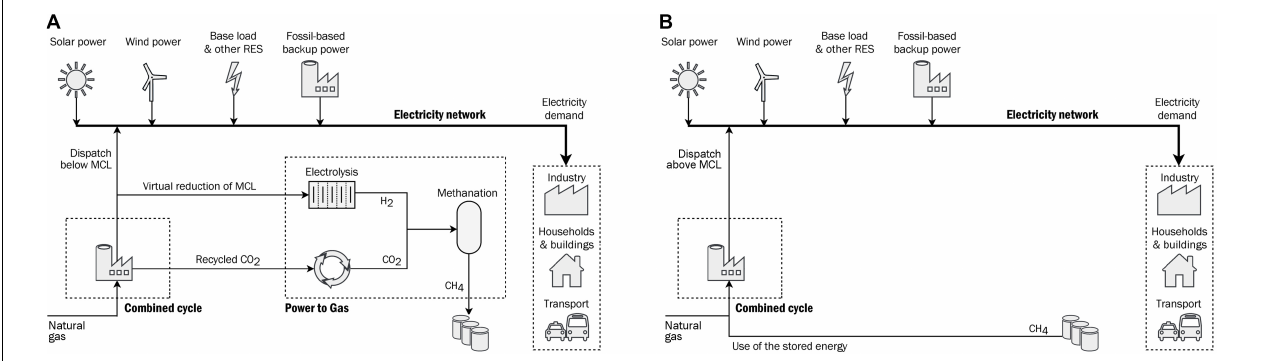
FIGURE 1 | Integration of power to gas and combined cycle power plant in the energy system: (A) Dispatch below minimum complaint load (MCL) diverting surplus electricity to power to gas. (B) Dispatch above MCL using stored energy.